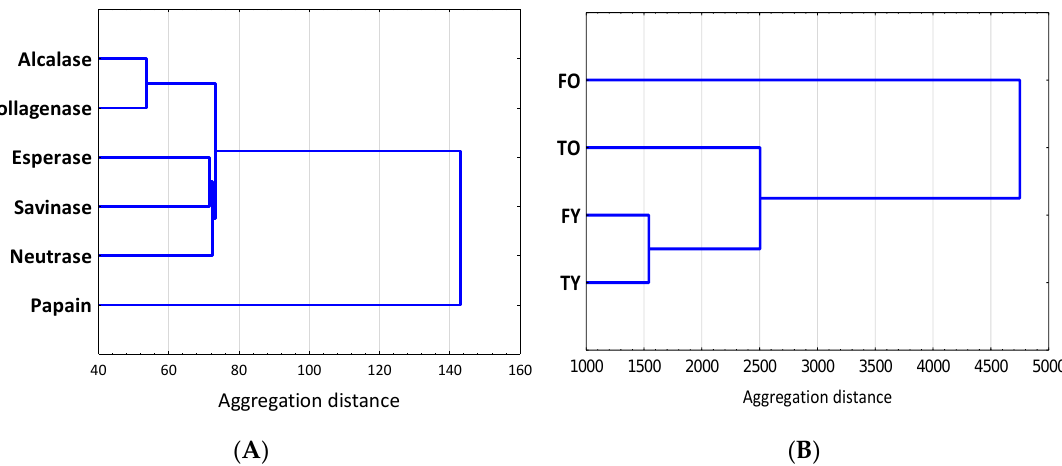
Figure 9. ( A ) Hierarchical clustering analysis (HCA) of enzymes on the basis of the antioxidant activities and for all the bones (FO, TO, FY and TY); ( B) HCA of bones based on antioxidants activities and amount of peptides released by each enzyme. FO = old femur, 10 years; TO = old tibia, 10 years; FY = young femur, 4.5 years; TY = young tibia, 4.5 years.